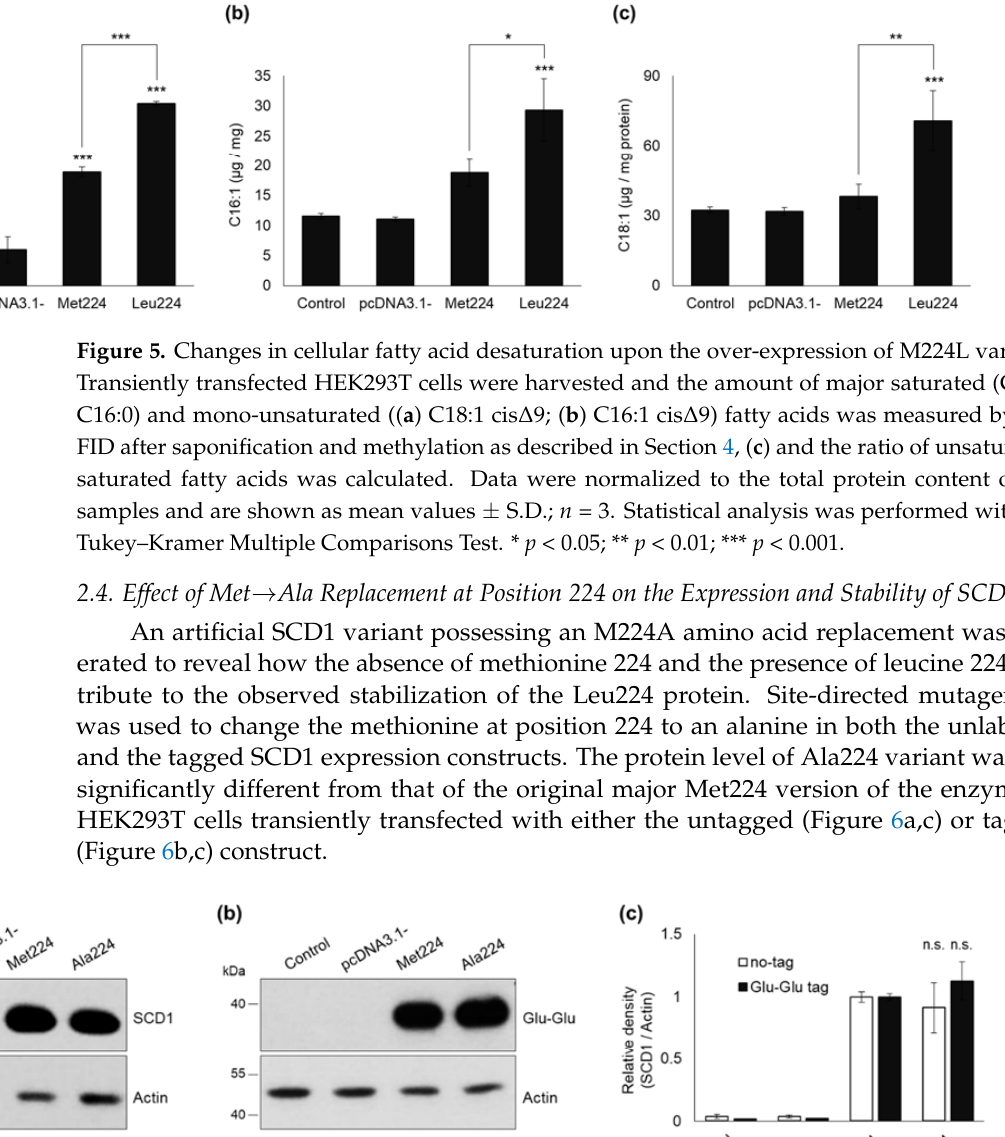
Figure 6. Intracellular protein level of Ala224 artificial SCD1 variant. HEK293T cells were harvested and processed 24 h after transfection. Aliquotes of cell lysates (5 µg) were loaded on 12% SDS-polyacrylamide gel, transferred to Immobilon-P membrane and SCD1 was detected with an anti-SCD1 ( a ) and an anti-Glu-Glu tag ( b ) antibody, respectively. Actin was measured as loading control. Representative immunoblots of three independent experiments are shown. The band intensities were quantitated by densitometry and SCD1/Actin ratios are shown as bar graphs ( c ). Data are shown as mean values ± S.D. Statistical analysis was performed with the Tukey–Kramer Multiple Comparisons Test. n.s.: non-significant difference 4 h after the translation arrest, the intracellular amount of Met224 SCD1 was reduced to approximately 25%, while about 50% of the Leu224 and Ala224 proteins could still be detected at the same time (see Figures 3a and 7a). Unlike the Leu224 version, however, the Ala224 protein level was not affected by oleate, palmitate, palmitoleate, linoleate, or stearate (Figure 7b). Also, to the contrary of Leu224 SCD1 , the mRNA level of Ala224 SCD1 was significantly, by about 30%, lower than that of the Met224 variant (Figure